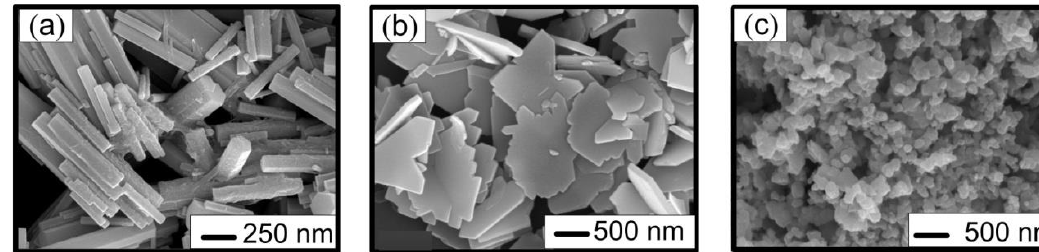
Figure 1. SEM images of submicron-sized crystallites of ( a ) h -MoO 3 , ( b ) h -WO 3 , and ( c ) V 2 O 5 xerogel used for preparation of heterostructure photocatalysts.